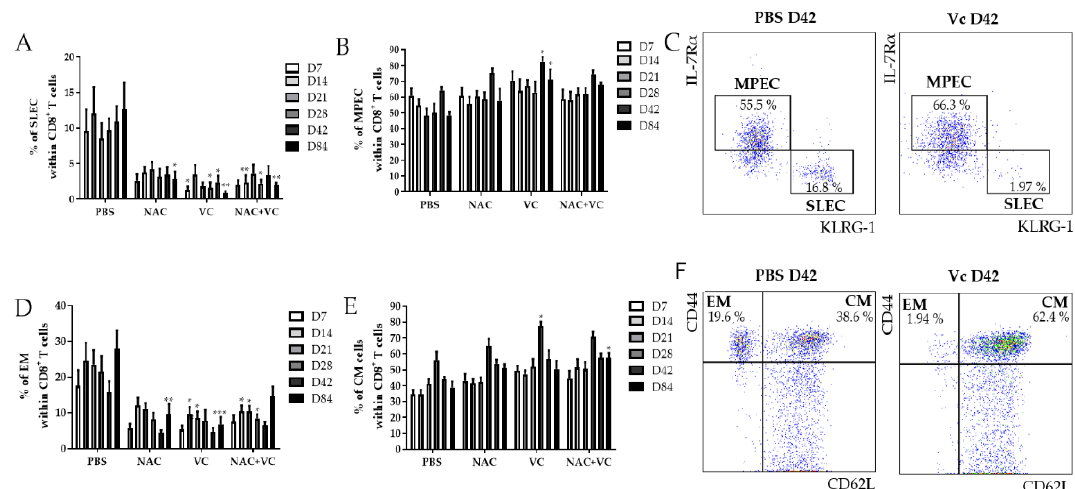
Figure 2. E ff ector / memory CD8 + T cell subsets in the PB of old mice. Frequency of ( A ) IL-7R α − KLRG-1 + SLEC and ( B ) IL-7R α + KLRG-1 − MPEC in the blood of old mice treated with PBS, NAC, Vc, or NAC + Vc. ( C ) Representative FACS plots of SLEC and MPEC in a control and in a Vc-treated old mouse on day 42. Frequency of ( D ) CD44 hi CD62L − EM and ( E ) CD44 hi CD62L + CM CD8 + T cells in the blood of old mice treated with PBS, NAC, Vc, or NAC + Vc. ( F ) Representative FACS plots of SLEC and MPEC in a control and in a Vc-treated old mouse on day 42. Blood was harvested on days 7, 14, 21, 28, 42, and 84. Data are shown as mean ± SEM. Two-way ANOVA, Tukey post-hoc test. * p < 0.05; ** p < 0.01; *** p < 0.001.